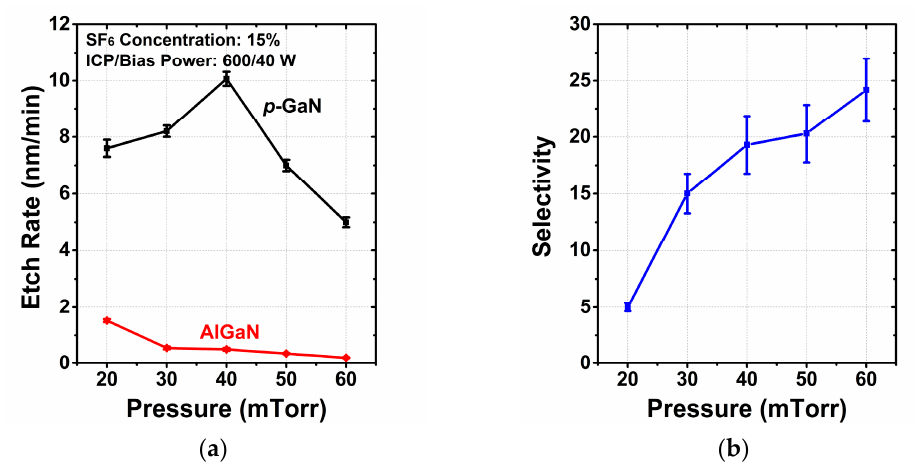
Figure 2. Dependence of ( a ) the etch rates, ( b ) selectivity between p -GaN and AlGaN on chamber pressure.